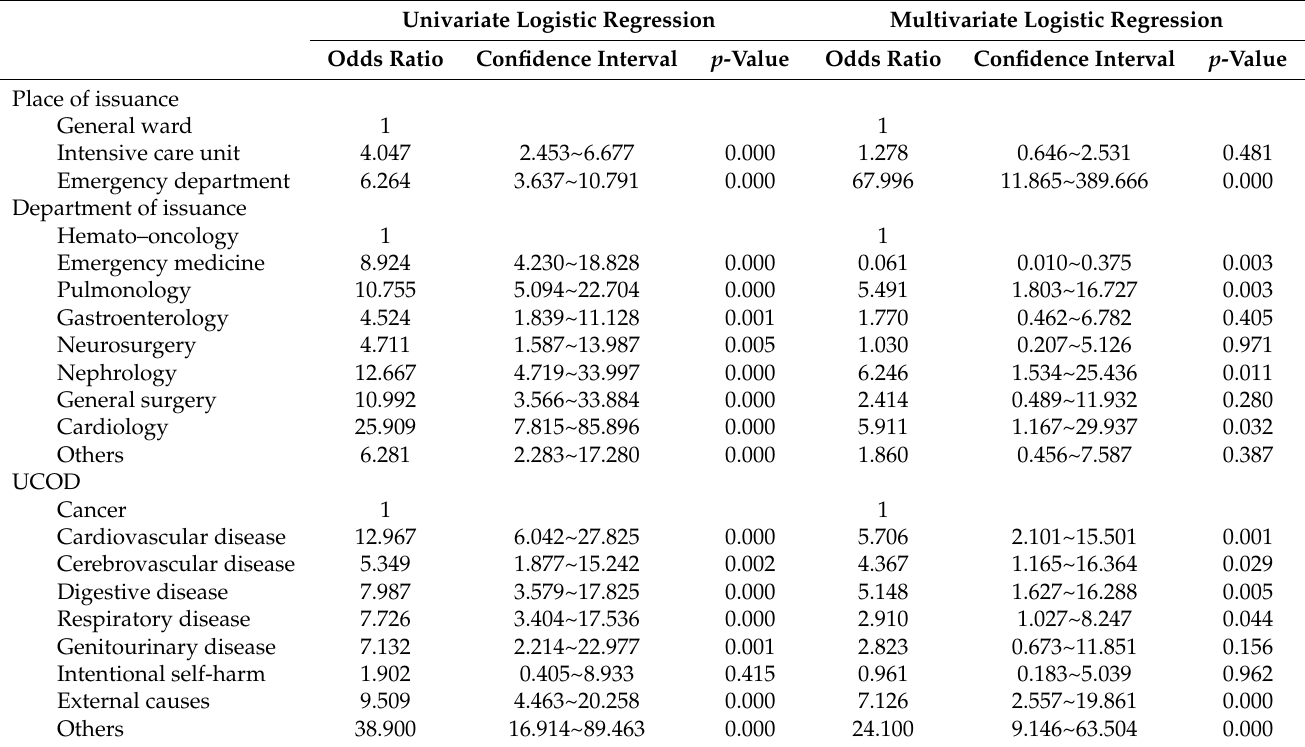
Table 3. Factors associated with major errors on death certificates.